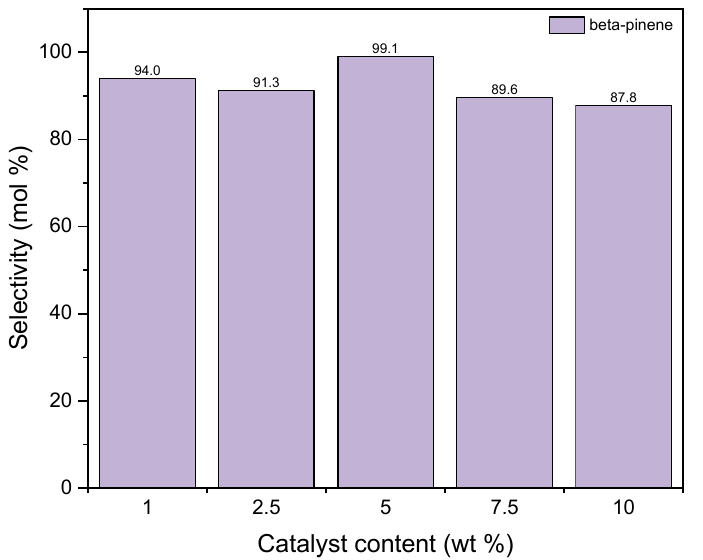
Figure 11. The influence of catalyst content on the selectivities of the appropriate products over diatomite as the catalyst.